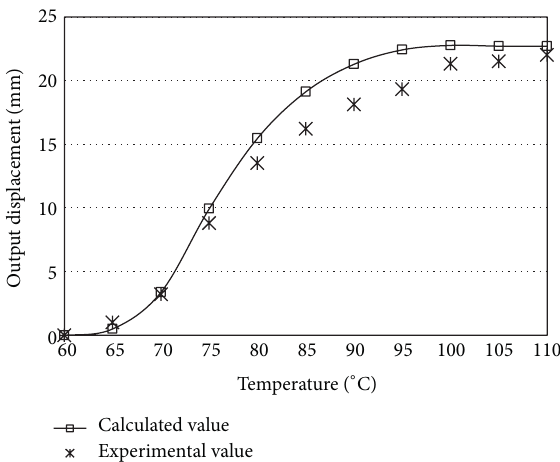
Figure 2: The displacements of SMA spring versus temperatures.